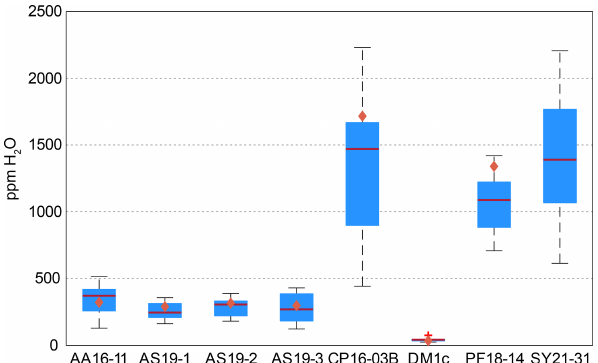
Figure 7. H 2 O contents for polarised and unpolarised measure- ments. Red lines give the median H 2 O content from polarised anal- ysis. Blue boxes depict the 25th and 75th percentile of the H 2 O content from polarised measurements; black dashed lines depict the total spread and the red cross for sample DM1c represents an out- lier. Orange diamonds relate to the H 2 O contents calculated from unpolarised measurements using average spectra and an orientation factor of 3.